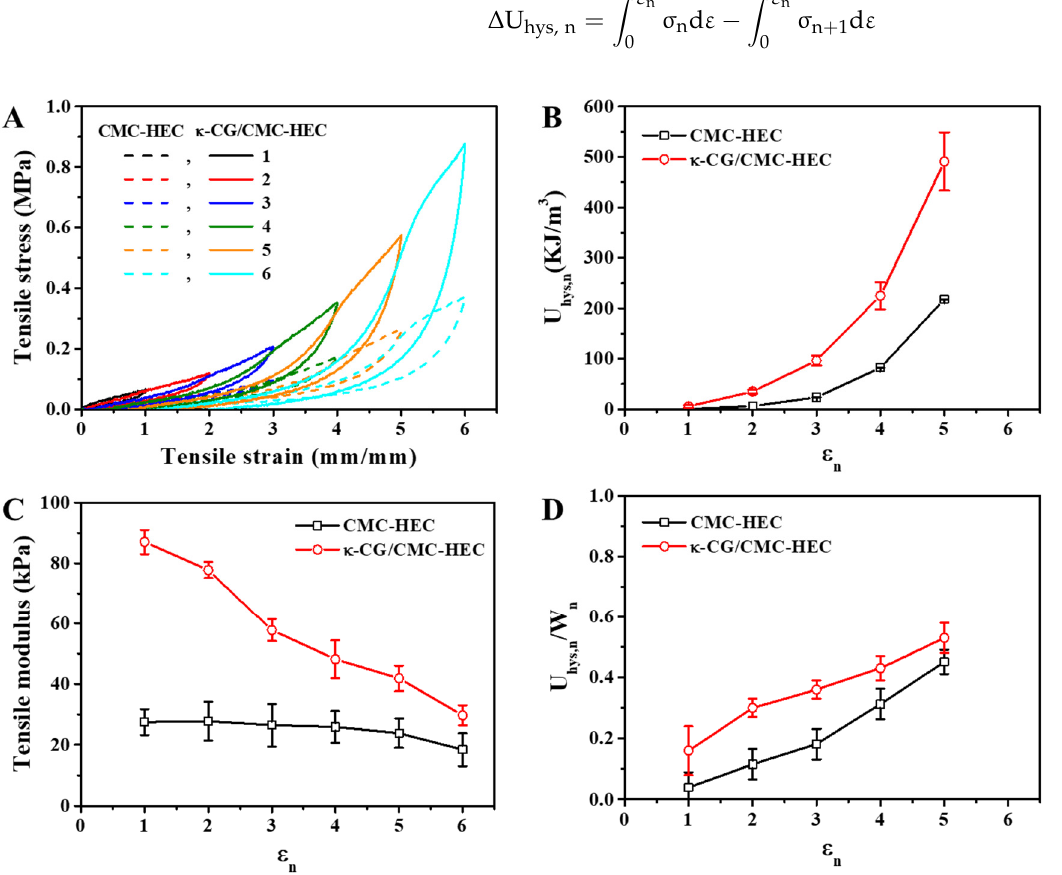
Figure 4. ( A ) Successive cyclic tensile loading–unloading curves of the CMC–HEC SN and κ‐ CG/CMC–HEC (1/25) DN hydrogels with increasing ε n and without any resting time between con- secutive loading cycles. The dependence of ( B ) U hys, n , ( C ) the tensile modulus, and ( D ) U hys, n /W n on ε n is shown.